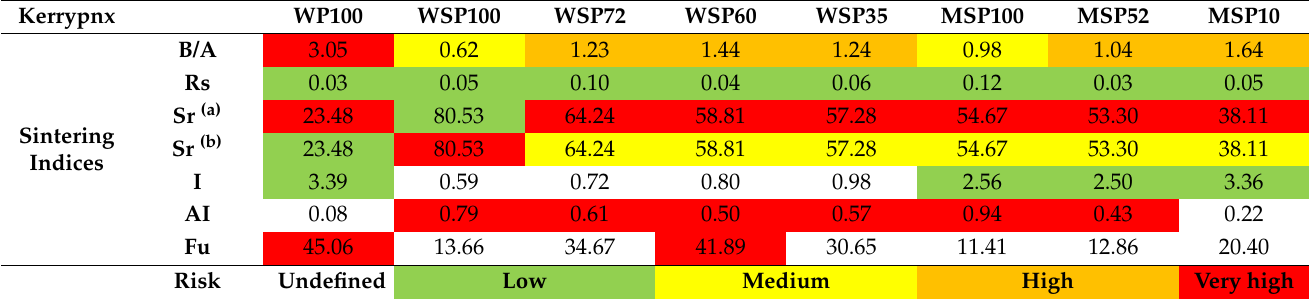
Table 6. Indices values to analyse